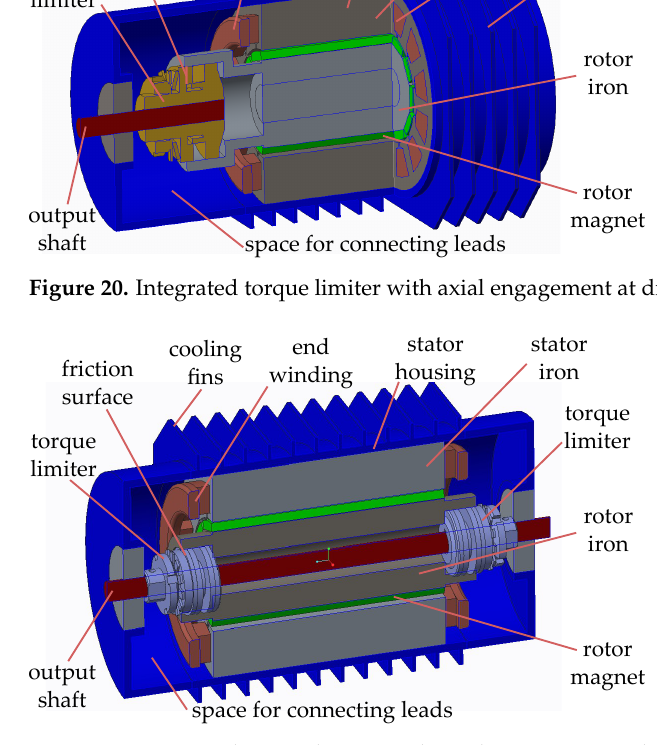
Figure 21. Integrated torque limiter with axial engagement at both sides of